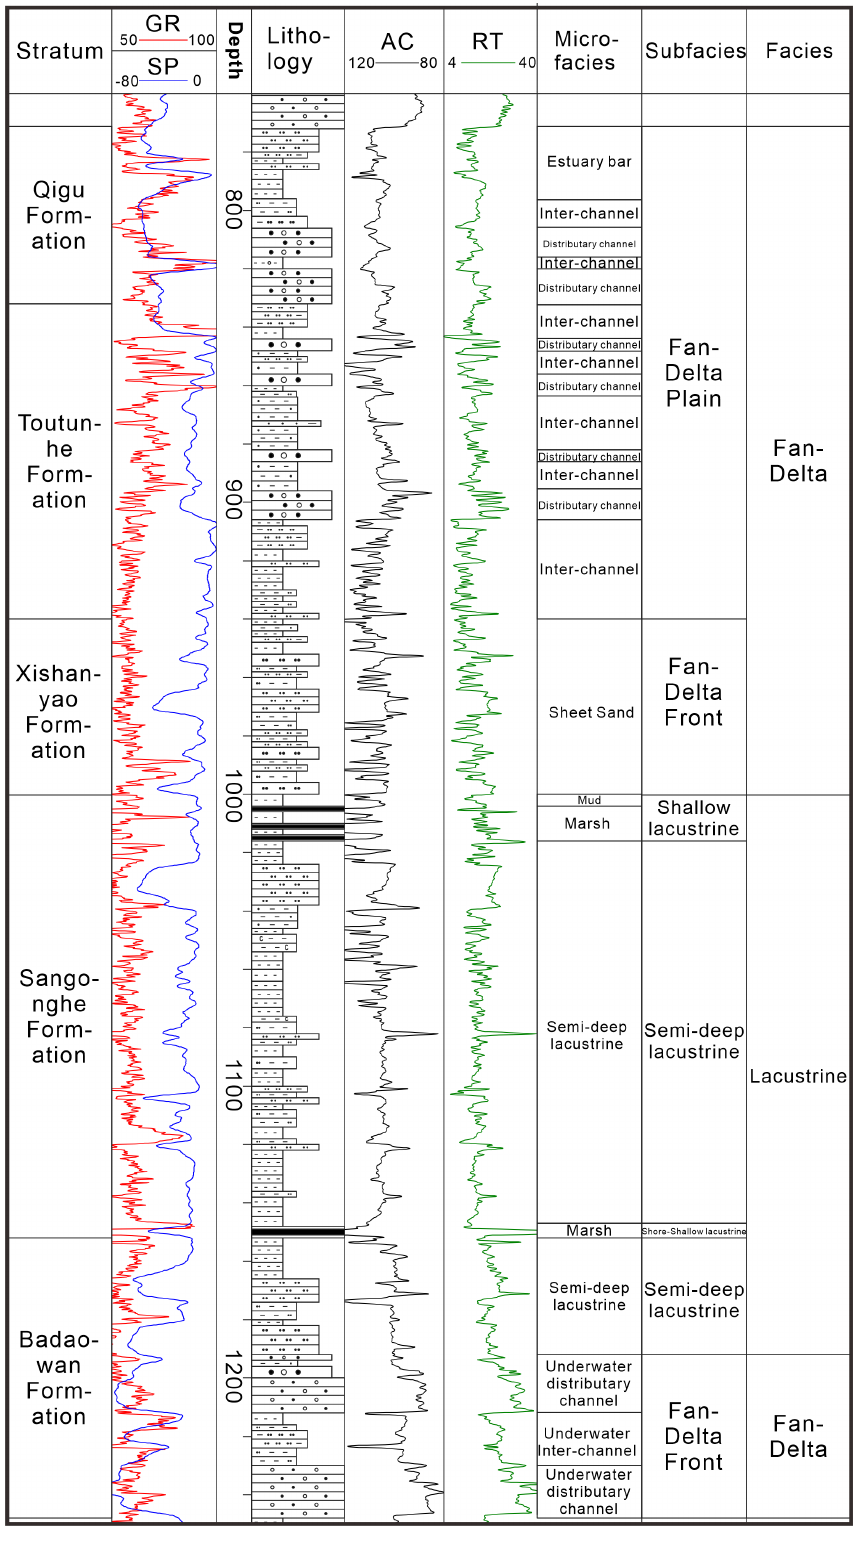
Figure 7. Single-well logging facies analysis of Well W112.